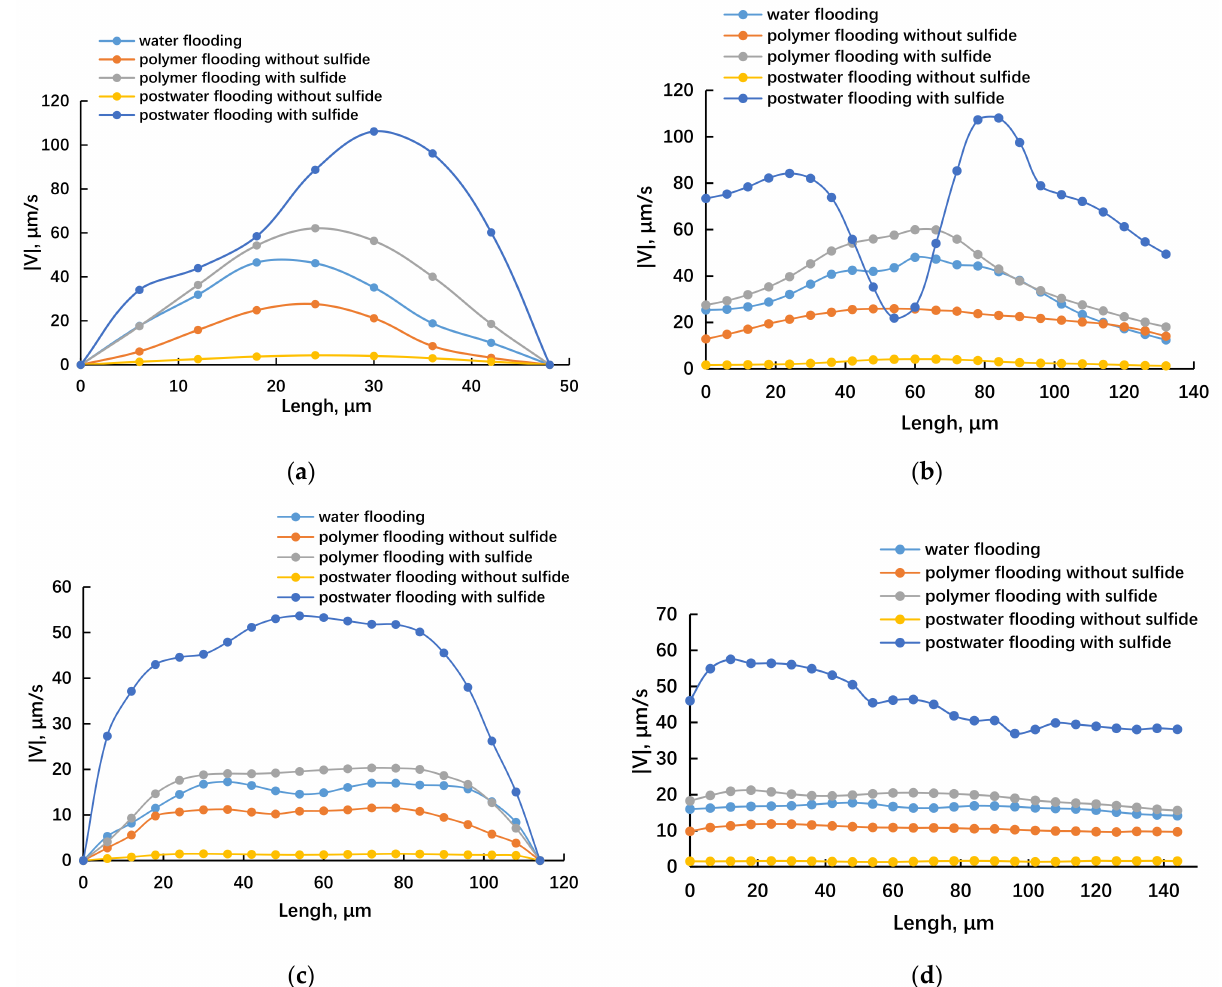
Figure 8. Velocity distribution in the throat (( a ) along Line 1 and ( b ) along Line 2 in Figure 6) and pore (( c ) along Line 3 and ( d ) along Line 4 in Figure